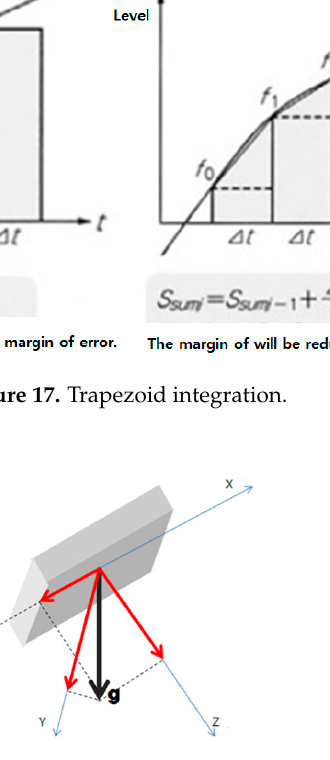
Figure 18. A Method of Measuring Position of Equipment.